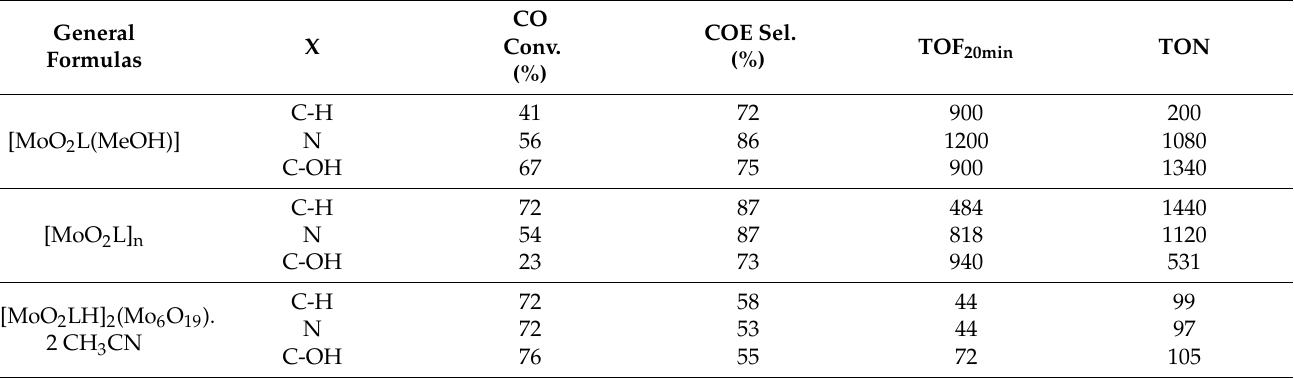
Figure 6. Schematic representation of neutral monomeric ( a ) polymeric ( b ) and charged mixed hybrid ( c ) species studied containing the pyridoxal fragment in the hydrazonato ligand. Table 3. Results of cyclooctene (CO) epoxidation and selectivity towards cyclo-octene oxide (COE) with MoO 2 L complexes from Figure 6.